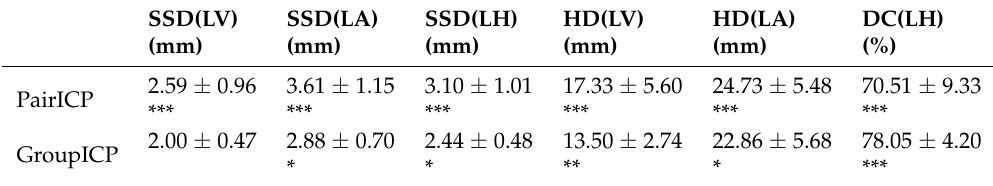
Figure 4. Training curves of the proposed method in six-folds. Table 2. ICP registration result comparison according to correspondence construction methods. This result is calculated with 35 cases under six-fold cross-validation.